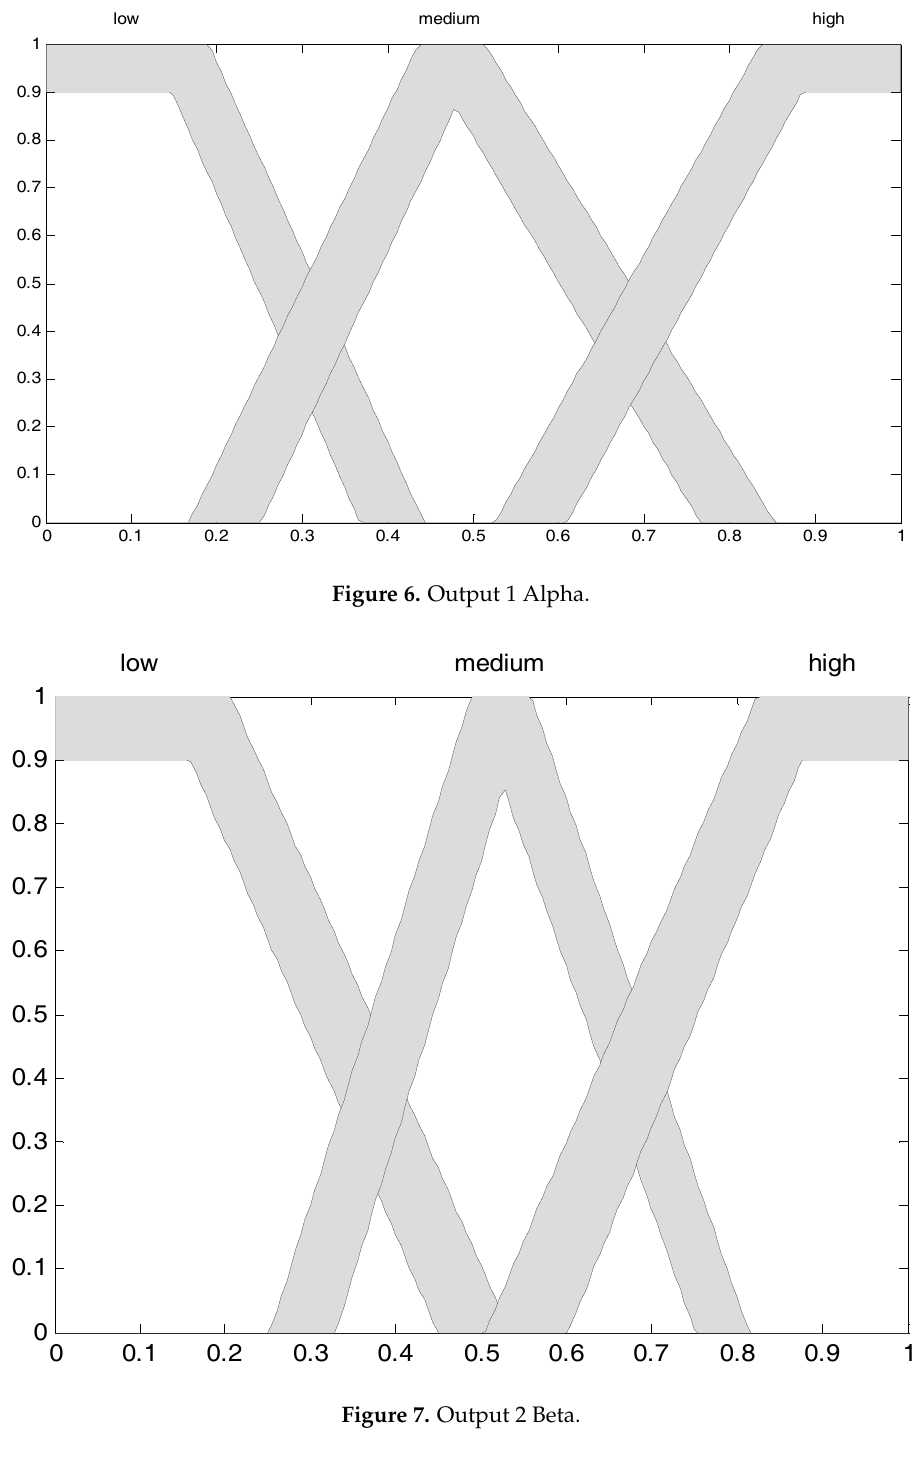
Figure 7. Output 2 Figure 7. Output 2 Beta Figure 7. Output 2 Beta